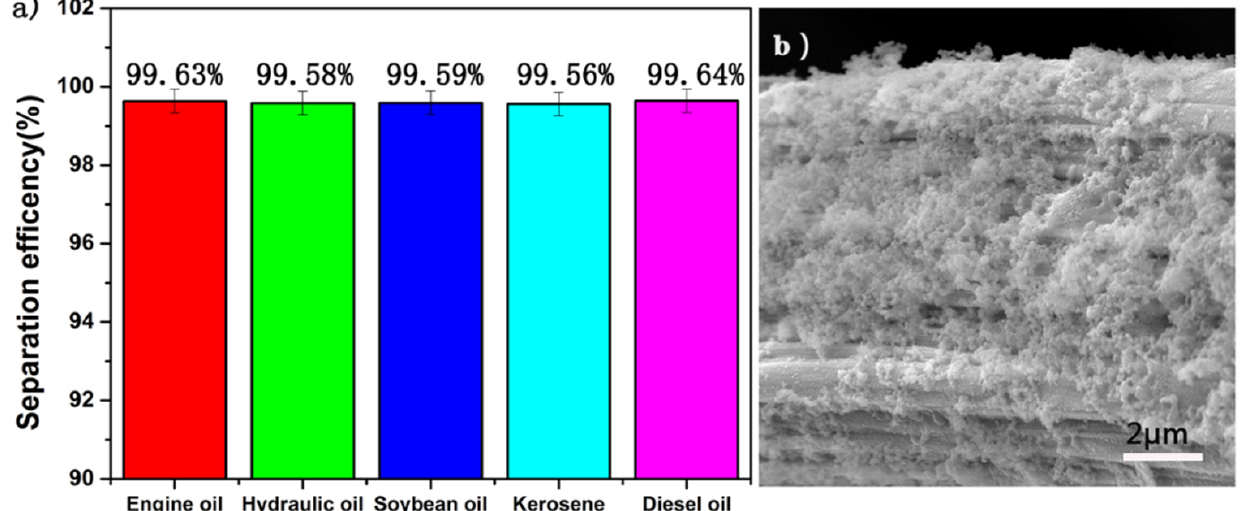
Figure 6. ( a ) The separation efficiency of SiO 2 -Na 2 SiO 3 -coated SSF after sandpaper abrasion and ( b ) the corresponding SEM image.